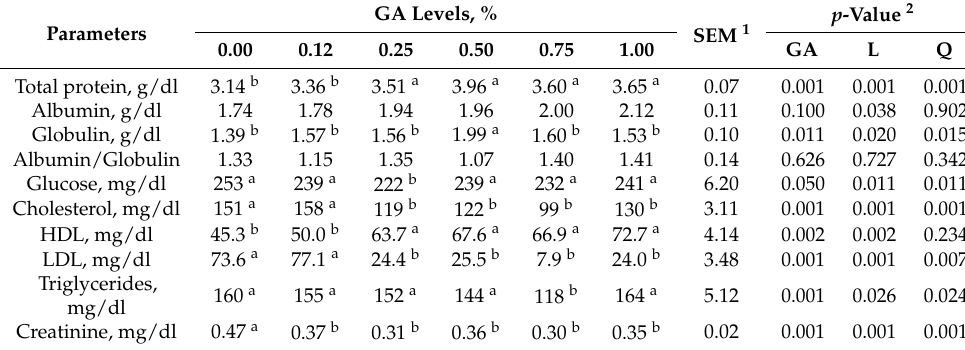
Table 6. Effect of gum Arabic (GA) on serum biochemical profile of male broiler chickens on d 10 of